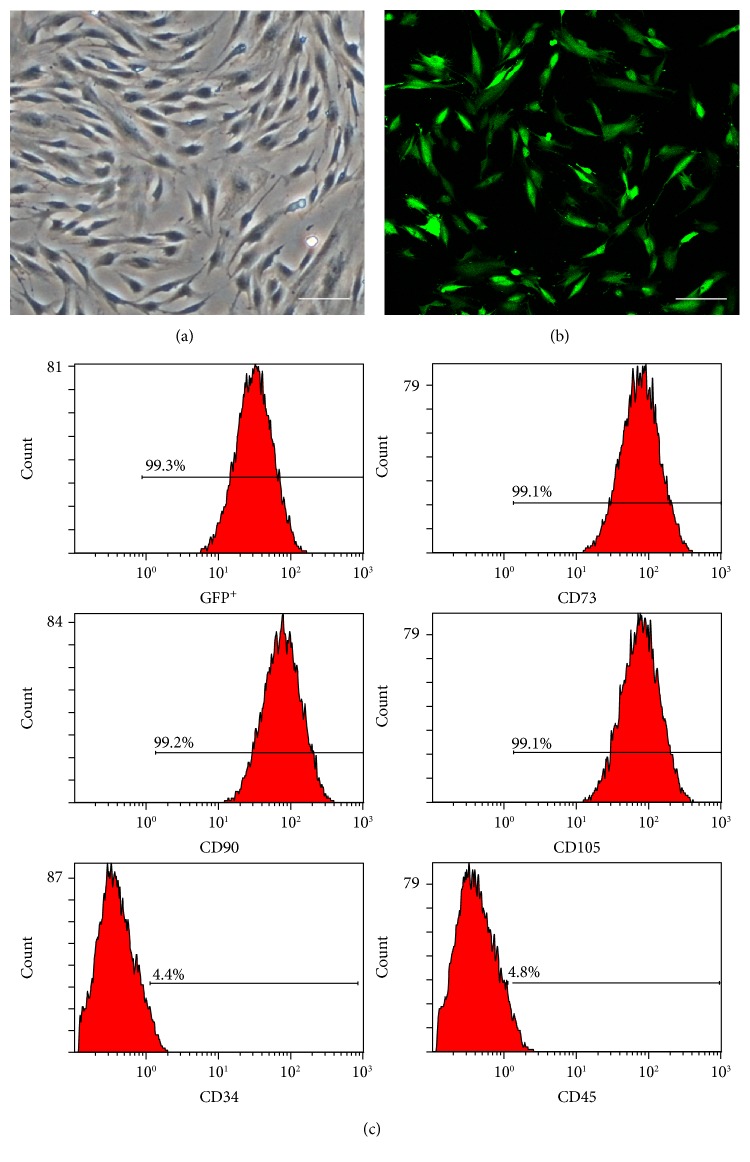
Human placental mesenchymal stem cell (hPMSC) morphology and phenotype profile. (a) hPMSCs without lentiviral transfection. (b) Three days after lentiviral transfection. (c) Surface antigen analysis of green fluorescent protein-positive (GFP+) hPMSCs (CD73, CD90, CD105, CD34, and CD45). Scale bars: 100 μm.